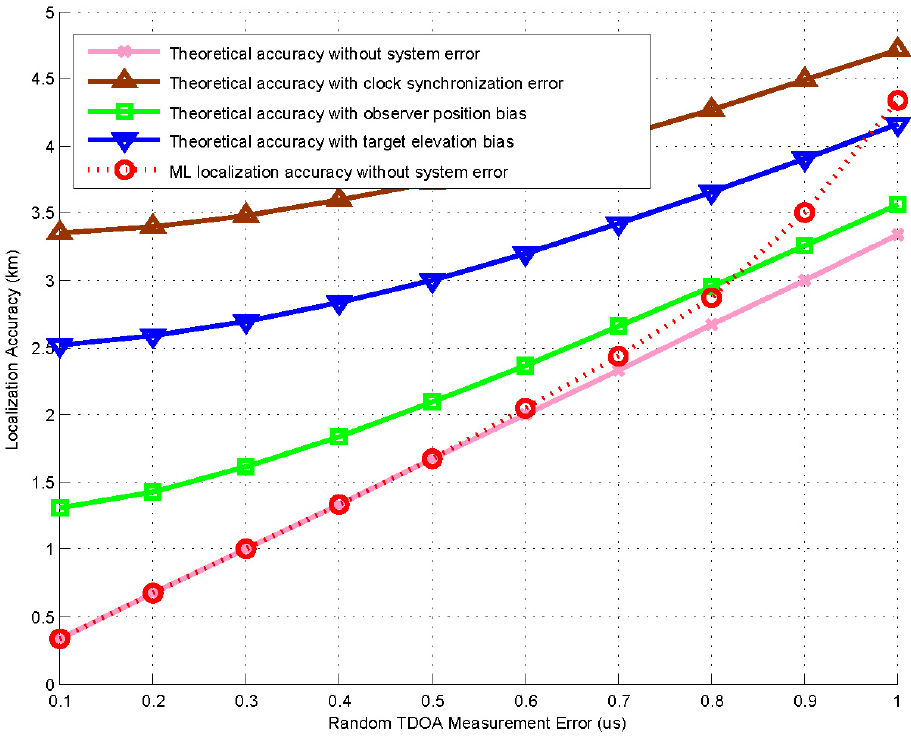
Figure 5. Localization accuracy comparison using the LEO and airplane by varying TDOA measurement noise.